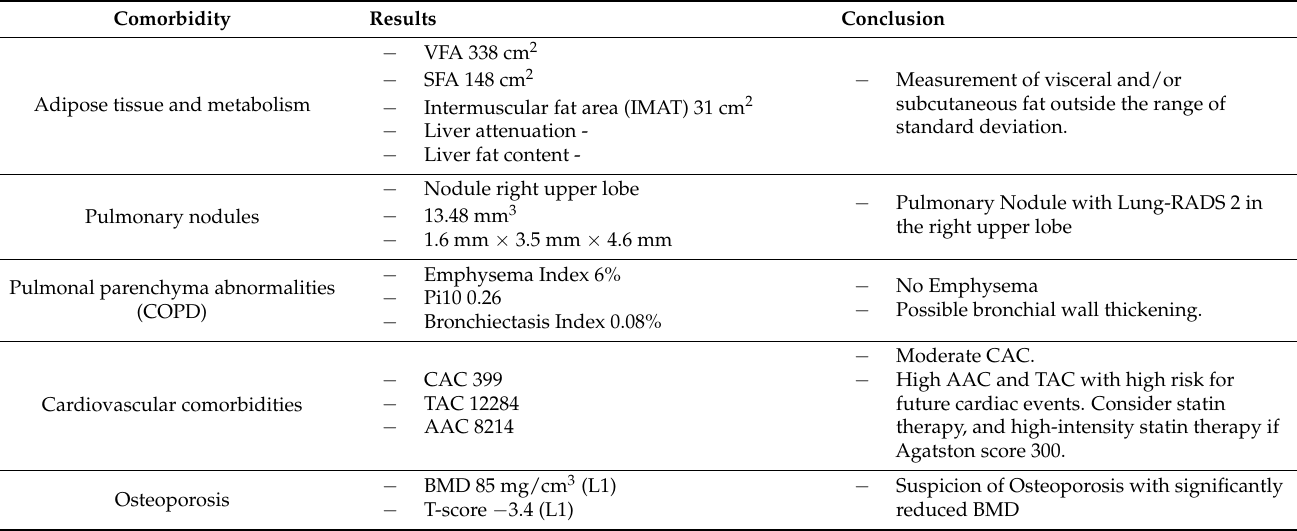
Table 2. Summary of the results of Example No. 1 ‘TAVI patient’.